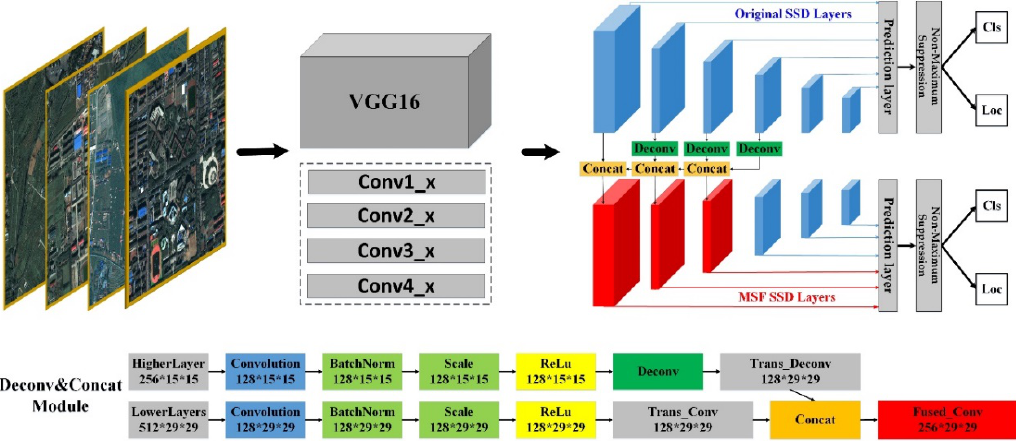
Figure 7. Networks of SSD and MSF_SSD on VGG16 network. The blue layers are added in the original SSD. The red layers are layers of the proposed MSF_SSD, which are achieved by “deconvolution” and “concat” module.